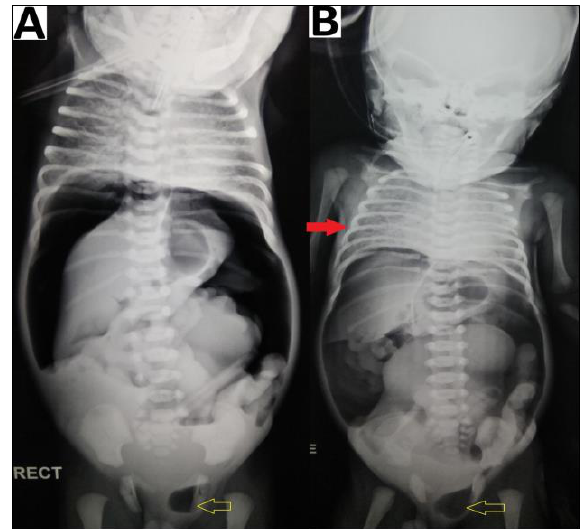
Figure 4: Abdominal radiographs (erect) (A) showing gas under the diaphragm, absence of gas-filled bowel loops, endotracheal tube in-situ, and features of pneumonitis; supine image (B) al- so showing pneumothorax (red arrow). Pneumoscrotum (yellow